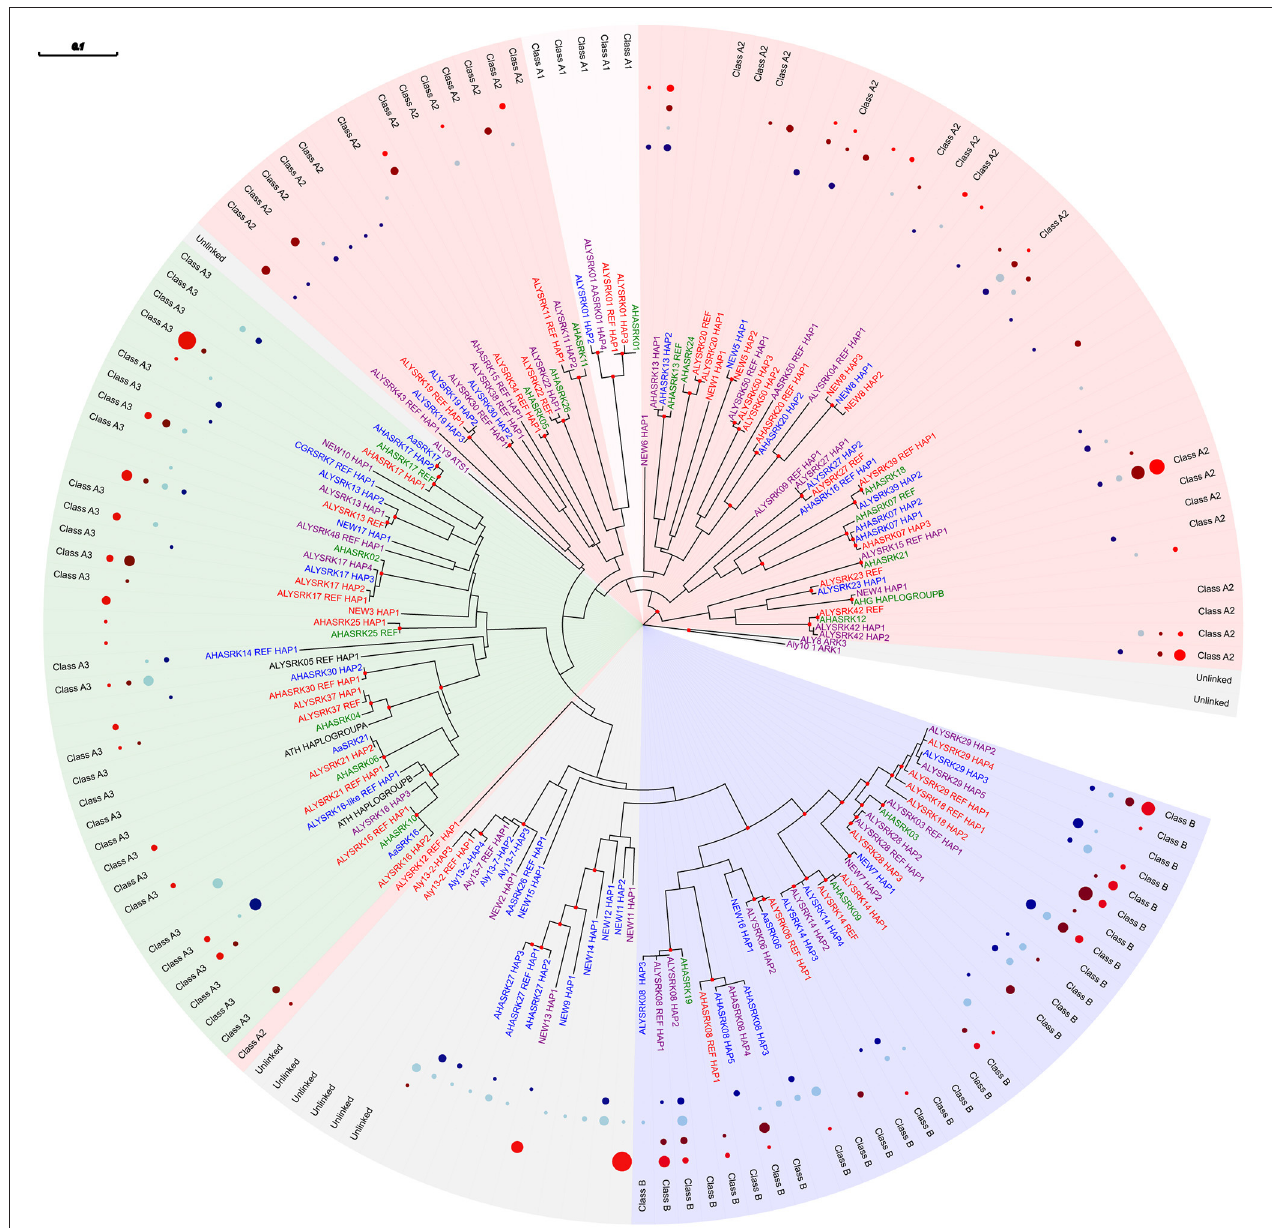
FIGURE 1 | Maximum likelihood tree based on SRK-like sequences resolved through 454 pyrosequencing, reconstructed using MEGA 7 under an HKY85 model of evolution with rate heterogeneity modeled under a gamma distribution and with proportion of invariant sites estimated. Bootstrap proportions above 70% are indicated as filled circles on nodes. The tree was rooted with the unlinked paralogs Aly 8 ( Ark 3 in A. thaliana ) and Aly 10.1 ( Ark 1 in A. thaliana ). Alleles for each SRK specificity are assigned to a dominance class based on previous studies of A. lyrata (Prigoda et al., 2005) and A. halleri (A1 = yellow; A2 = red; A3 = green; B = blue; unlinked = gray); new alleles or previously identified alleles where dominance has not been confirmed are colored according to the class predicted by their position in the tree. Tip labels are colored according to the species in which they were found in the 454 sequences (lyrata = red; lyrata + arenosa = purple; arenosa = blue) or the origin of the reference allele in cases where there was no exact match (halleri = green; thaliana = black). Also shown is the frequency of a particular haplotype in each of the four groups compared (diploid arenosa, A2x = dark blue; tetraploid arenosa, A4x = light blue; diploid lyrata, L2x = dark red; tetraploid lyrata, L4x = light red). Due to the high number of haplotypes but low read numbers for AlySRK 01 and the unlinked loci Aly 13-2 and Aly 13-7, only a subset of haplotypes are included and frequencies are not